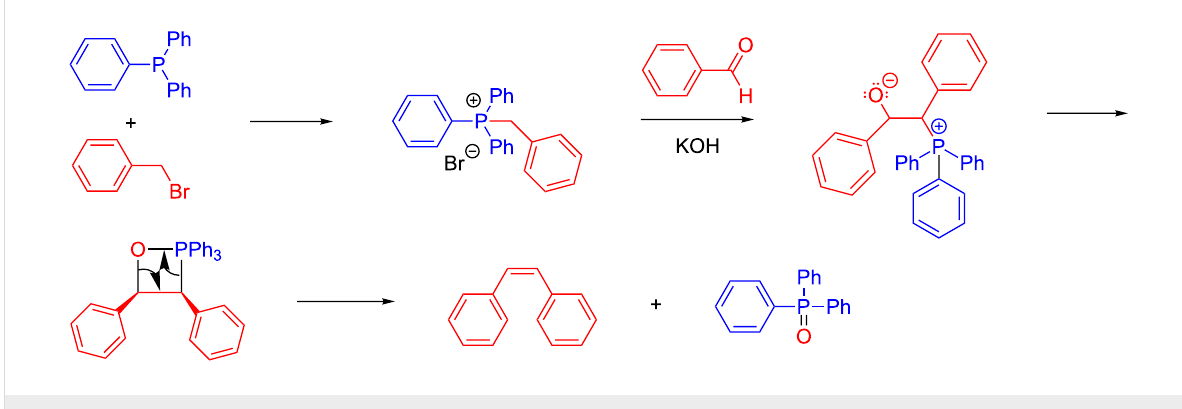
Figure 1: Solution-based Wittig reaction mechanism.